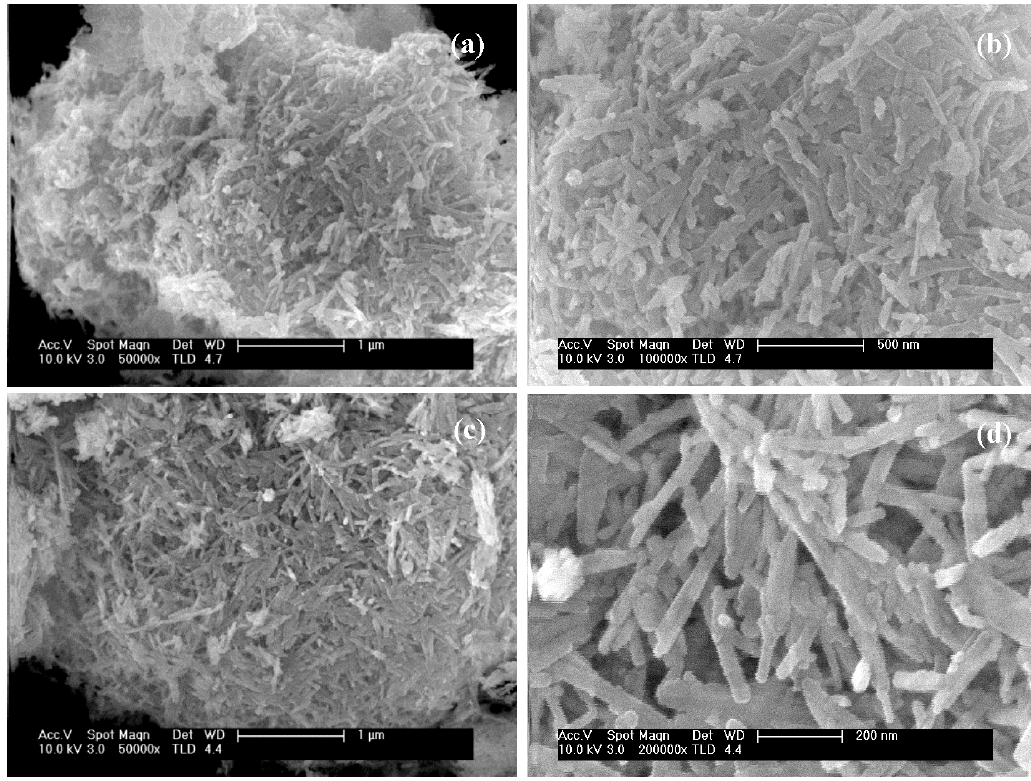
Figure 4. FE-SEM images of CdS samples prepared with different H 2 O/thiourea ratio: ( a , b ) CdS-1.3 and ( c , d ) CdS-3.0.